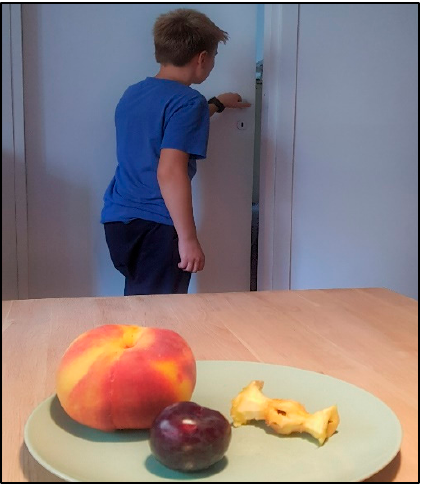
Figure 1. Picture associated with (31)